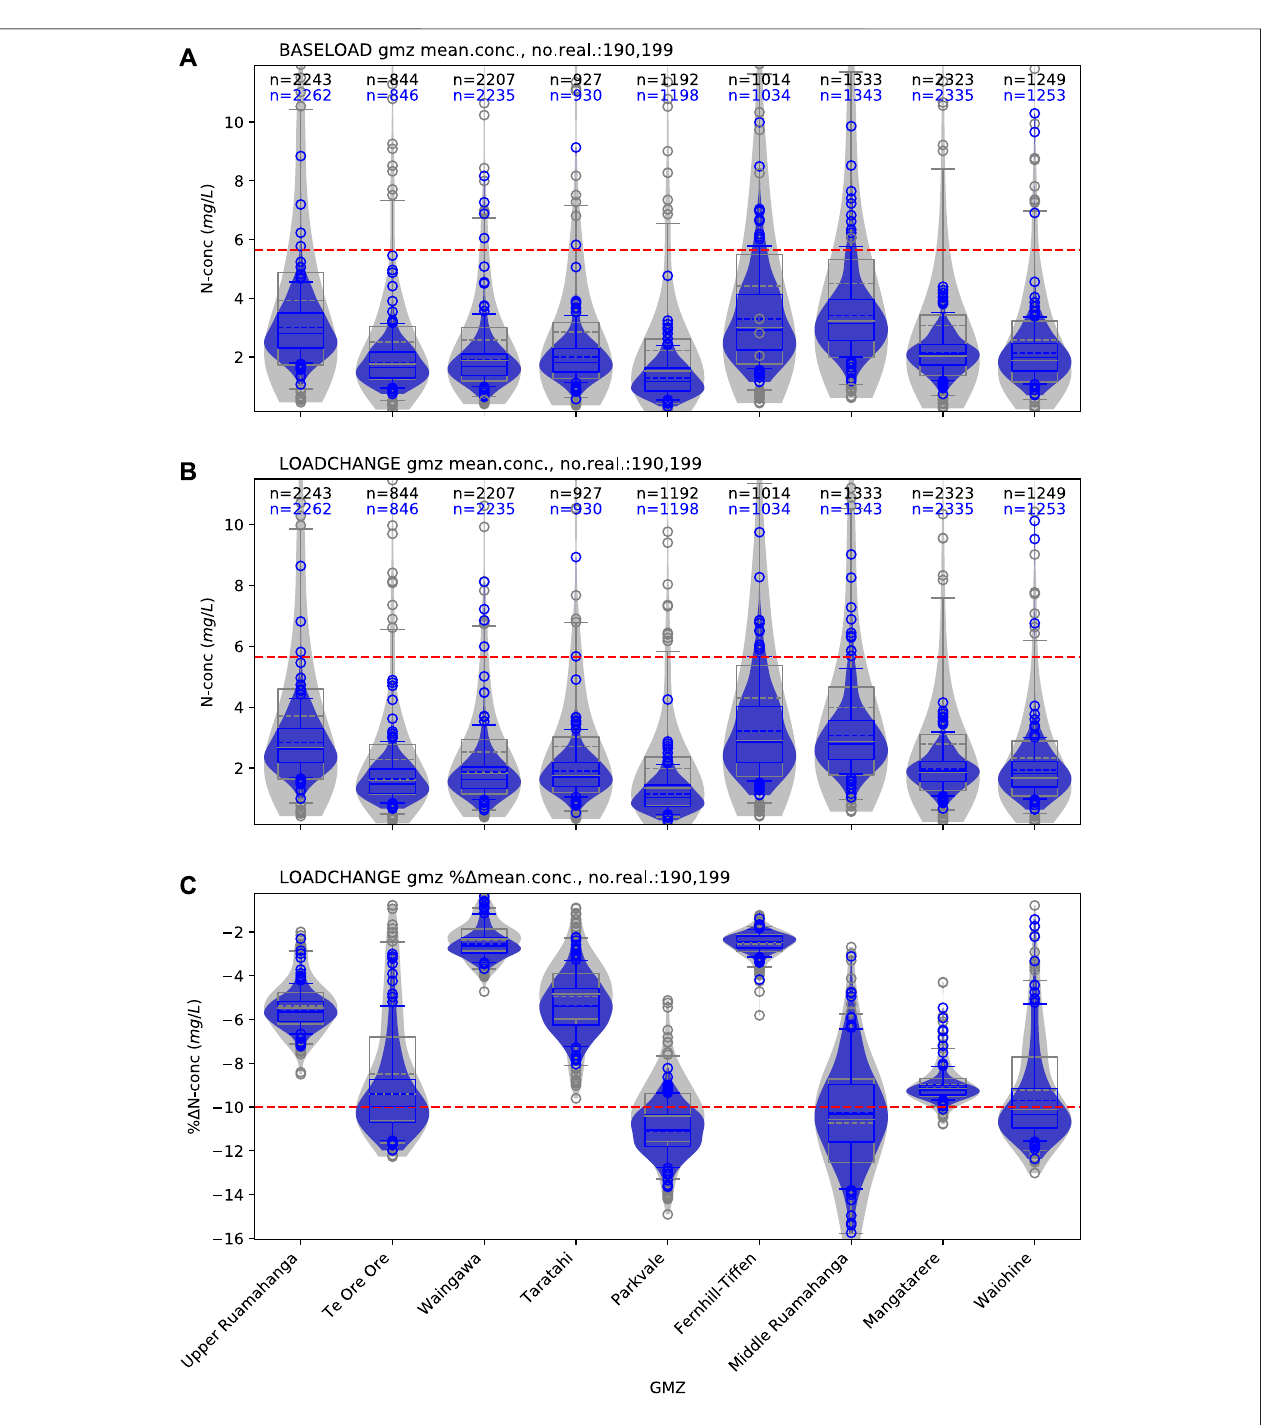
FIGURE9 | Water quality prior (grey) and posterior (blue) forecasts distributions for mean zonal concentration in GMZs (see Figure 2 ).The width ofthe distribution indicates the distribution density. Box plots are also displayed to indicate the inter-quartile range (IQR, Q3-Q1, box), median (line in box), and 5th and 95th percentile (whiskers) of the distributions. Red dashed lines represent decision threshold values; for absolute mean zonal concentration forecasts ( mean.conc , A and B ) this threshold is 5.65mg l – 1; for percentage-change forecasts ( %mean.conc , C ), the threshold is10% reduction in concentration. “ no.real. ” details the number of realization completed — therefore the number represented in the PDF — for prior and posterior ensembles, respectively. In A and B , “ n ” represents the mean number of activemodelcellsineachzone,acrossallprior(blacktext)andposterior(bluetext)realizations. “ LOADCHANGE ” representstheland-usemanagementscenarioexplored relative to the baseline (denoted as “ BASELOAD ”